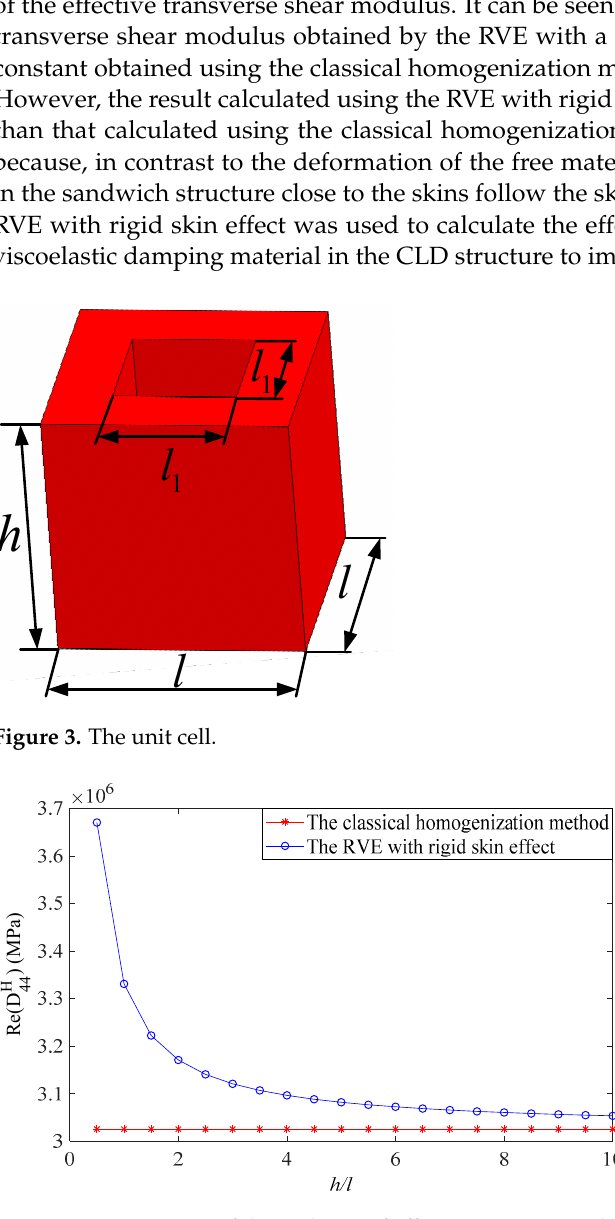
Figure 4. Comparison of the real part of effective transverse shear modulus.